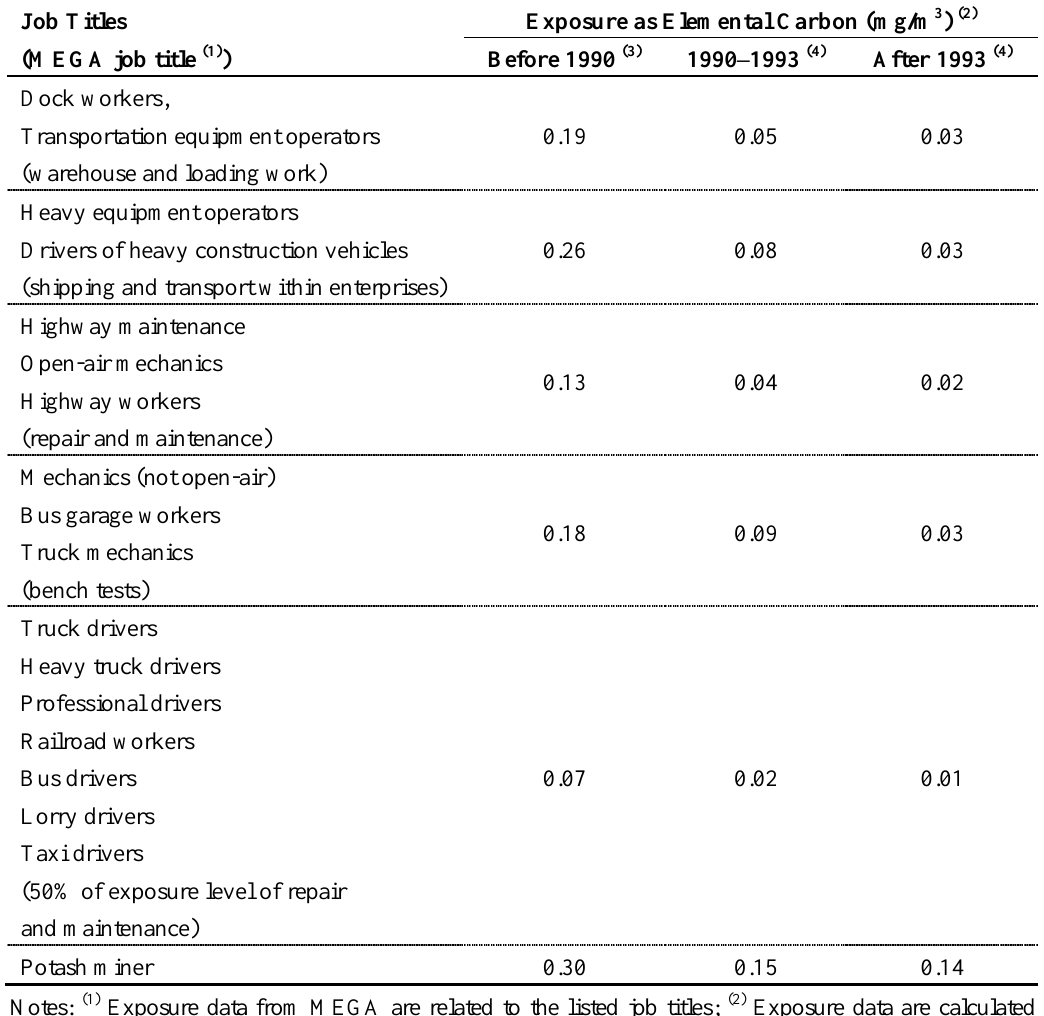
Table 1. DE exposures in common exposed jobs in Germany